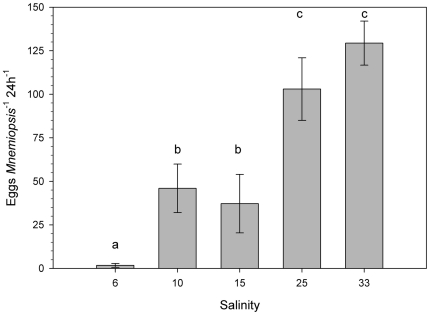

Mnemiopsis leidyi egg production at salinities representative for different hydrographic regimes of the Baltic Sea.Laboratory reared animals (mean oral aboral length 15.1±1.8 mm, n = 4–5) were individually incubated and mean egg production per salinity is stated 24 h−1 as bars ±SE. Egg production rates differed significantly (F = 41.33, p<0.0001, df = 22) with salinity forming 3 clusters of 33/25, 15/10 and 6 (Student-Newman-Keuls post hoc test with significant groups indicated by letters a–c).